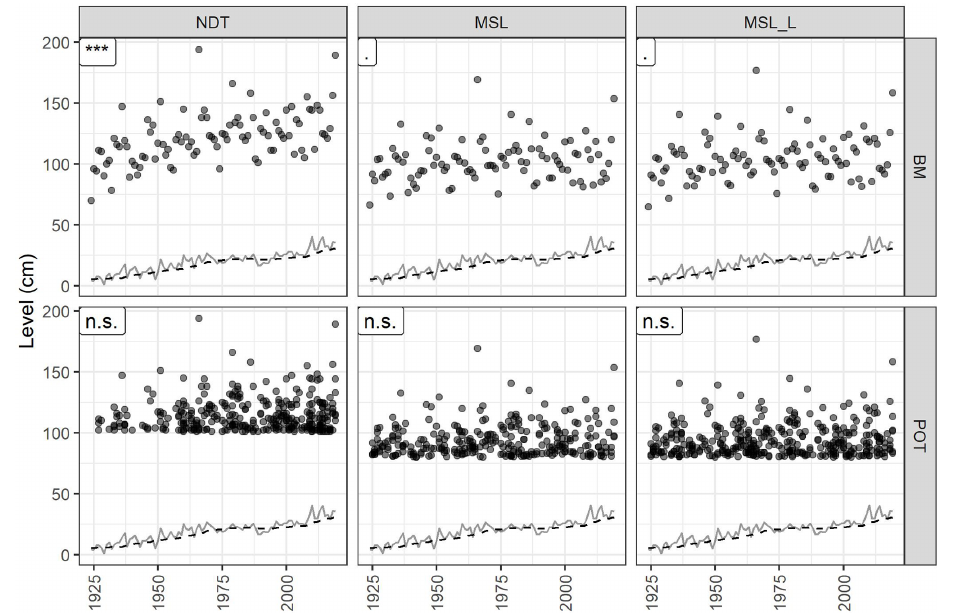
Figure 2. Venice data used to fit the models. See Fig. S2 for Marseille data. Plots are grouped vertically according to the detrending (BM: block maxima; POT: peaks over threshold). The text in the label in the top left corner of each plot shows the significance level